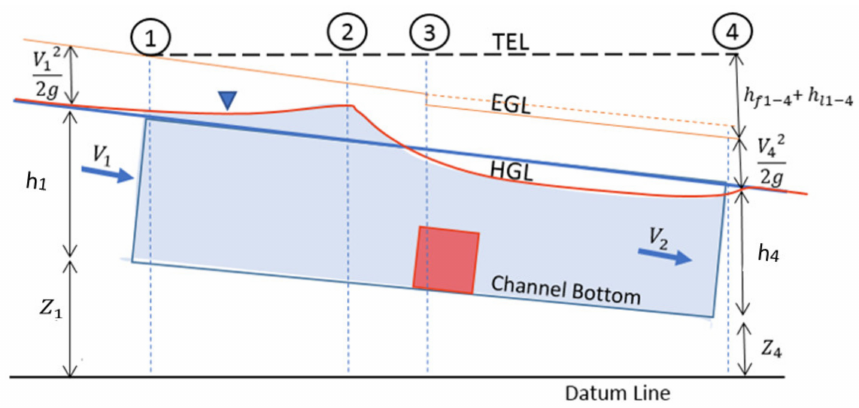
Figure 10. Energy